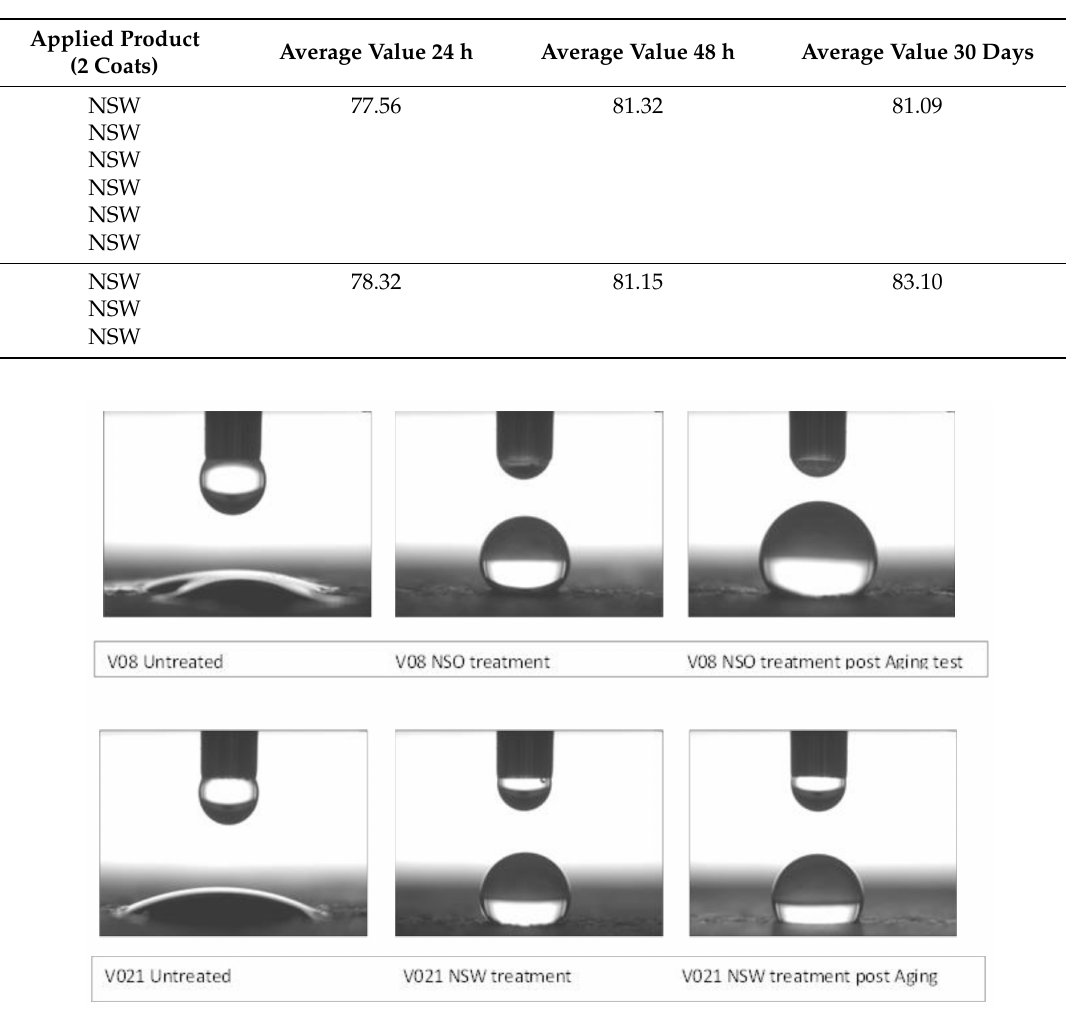
Figure 6. Contact angle